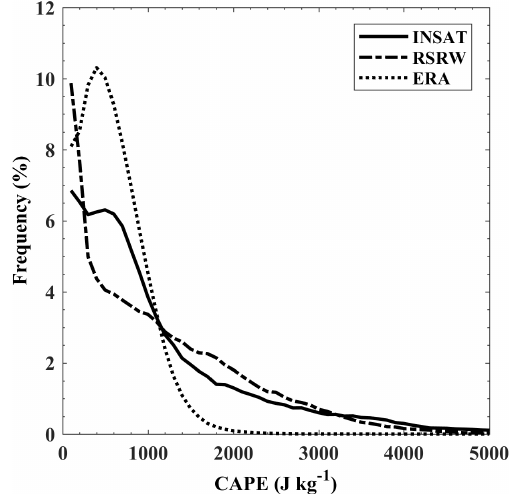
Figure 5. Distribution (%) of INSAT-3D, radiosonde and ERA- Interim reanalysis CAPE (Jkg − 1 ) for all the stations considered in the